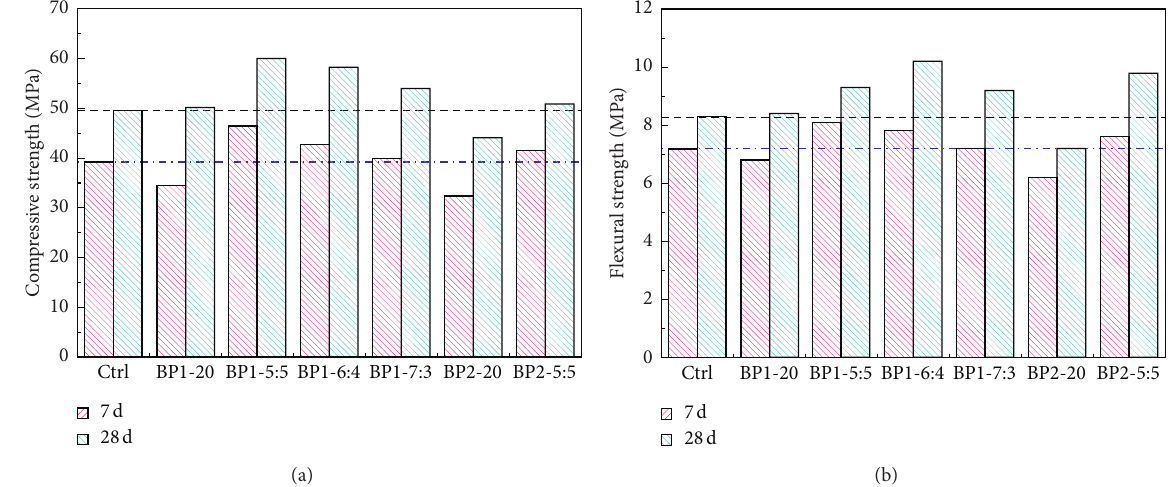
Figure 4: The effect of brick powder-silica flour on the (a) compressive strength and (b) flexural strength of cement